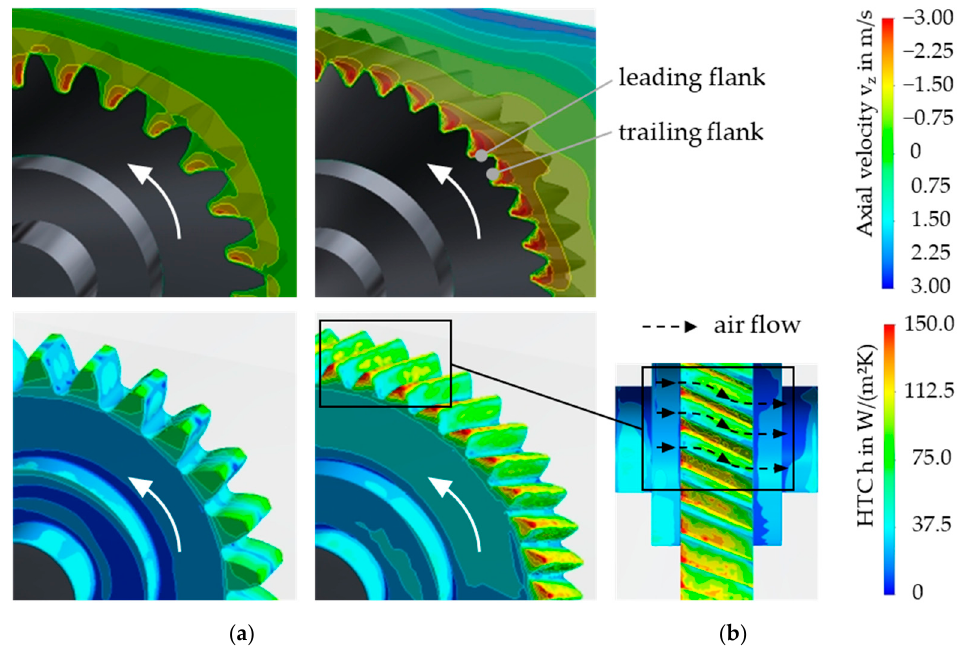
Figure 9. Detailed view on axial flow velocity (z-direction) and HTC between gear surface and air for the wheels of gear-C ( a ) and gear-LL ( b ) for v t = 10.0 m/s.